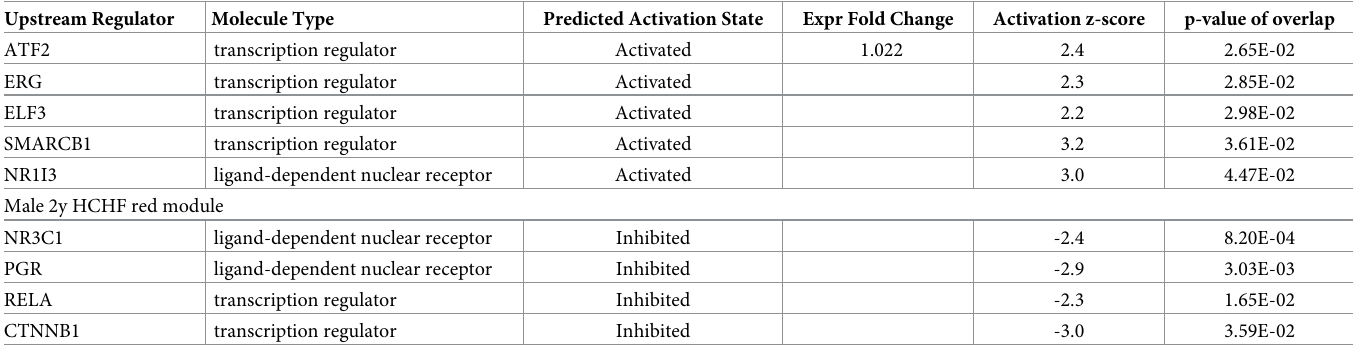
PLOS ONE | https://doi.org/10.1371/journal.pone.0271514 August 4,